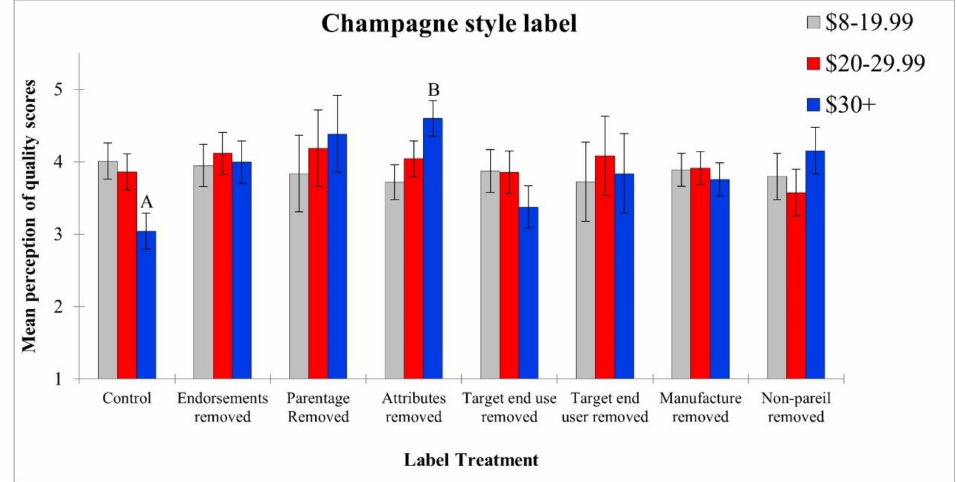
Figure 6. Perception of quality for Champagne-style wine (5-point Likert scale; n = 572) +/ − SE— interaction between label treatments and price typically spend per bottle of sparkling wine. Letters above bars represent significantly different groups across all label treatments (Tukey’s (HSD 0.05 ) following two-way